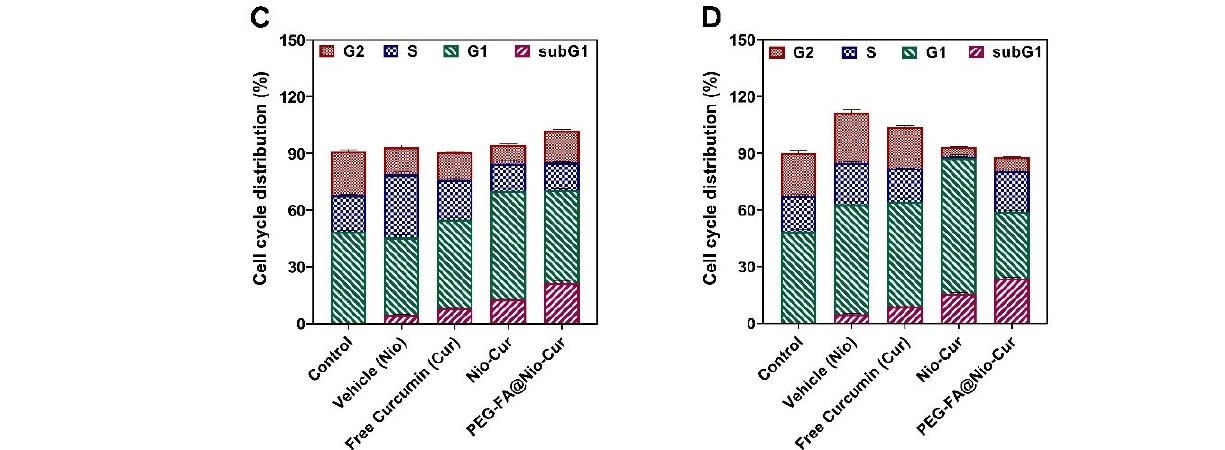
Figure 5. The effects of control, Cur, and different niosome formulations vehicle (Nio), Nio-Cur and PEG-FA@Nio-Cur of ( A ) MCF7 and ( B ) 4T1 breast cancer cells on cell cycle distribution after 48 h of treatment. Data represent means ± standard deviations ( n = 3). ( C , D ) Cell cycle distribution for ( C ) MCF7 and ( D ) 4T1 cells after treatment with IC50 concentration of vehicle (Nio), Cur, Nio-Cur, and PEG-FA@Nio-Cur formulations.